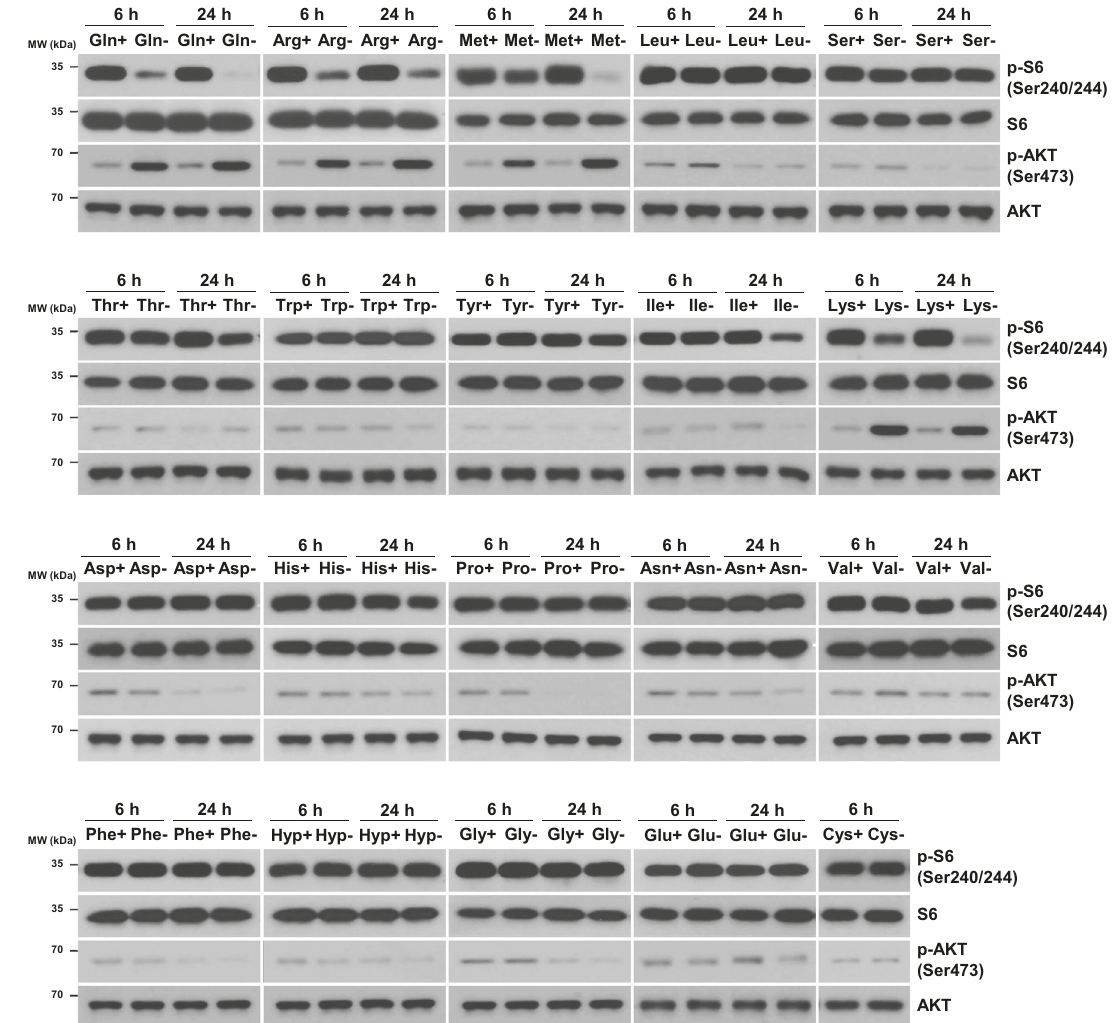
Fig. 3 mTORC1 and mTORC2 activity under individual amino acid-de fi cient conditions. H1299 cells were deprived of each one of 20 amino acids in medium for 6 or 24 h. The levels of phosphorylated S6 (Ser240/244) and AKT (Ser473) were measured by western blot